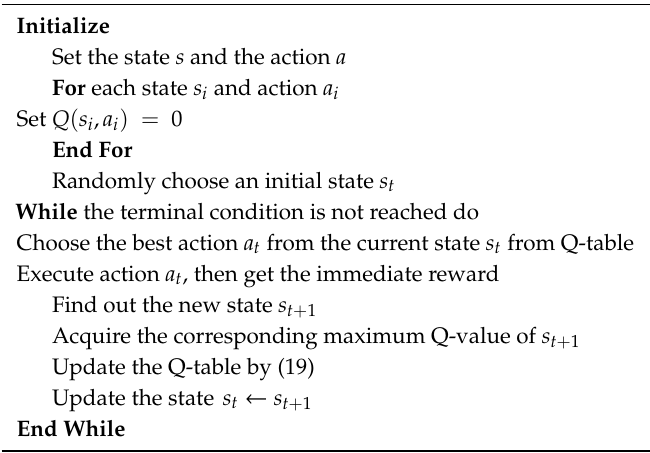
Algorithm 1. The Q-learning method